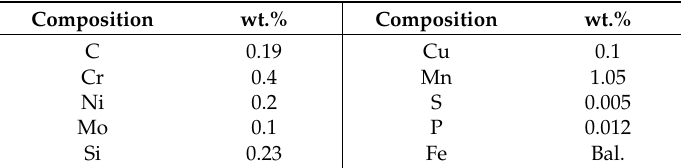
Table 1. Chemical composition of the carbon steel substrate (wt.%).